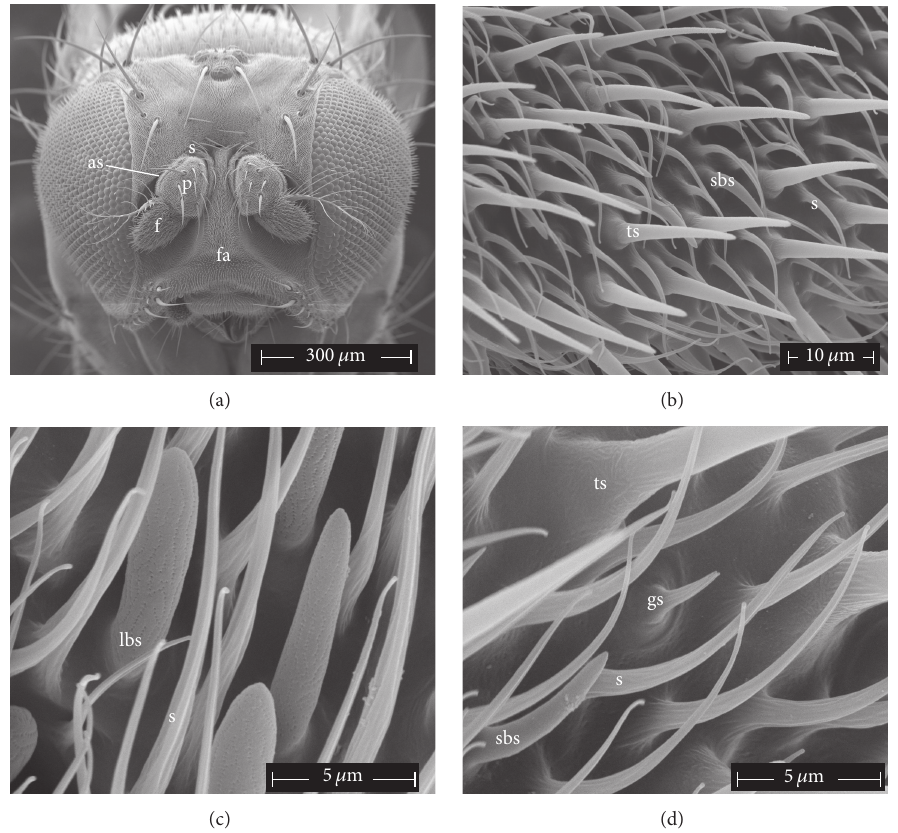
Figure 4: Scanning electron micrographs of D. melanogaster WT male. (a) Head showing the antennal pattern: scape (s), pedicel (p), antennal seam (as), flagellum (f), and face (fa). (b) Magnification of the central part of flagellum with sensilla: trichoid sensillum (ts), small basiconic sensillum (sbs), and setae (s). (c) High magnification of the basal part of the flagellum showing some large basiconic sensilla with porous wall (lbs). (d) High magnification of different types of sensilla in the central part of flagellum with a grooved sensillum